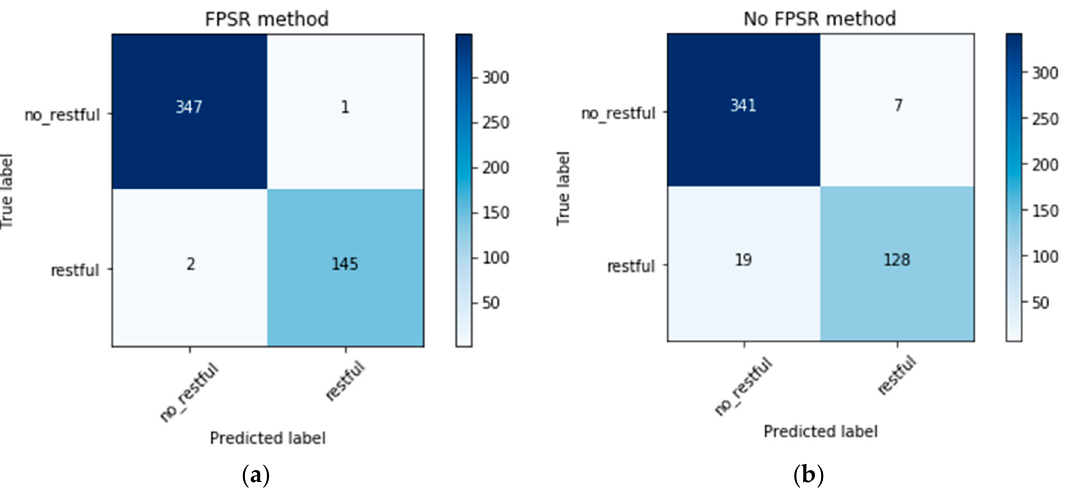
Figure 7. ( a ) The confusion matrix with the FPSR method; ( b ) The confusion matrix without the FPSR method. FPSR